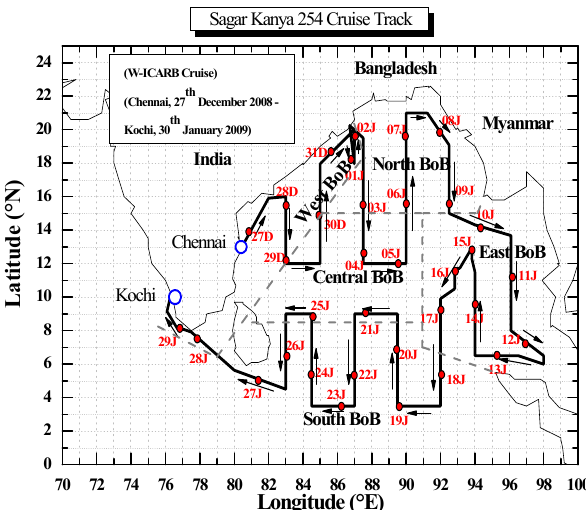
Fig. 1. The cruise track of Sagar Kanya 254 in the Bay of Bengal during the W-ICARB, 27 December 2008–30 January 2009. The arrow shows the track of the ship while the circles show the position of the ship at 10:30LST for each day. The entire BoB is divided in 5 sub-regions, namely (a) west, (b) north, (c) east, (d) central, and (e)